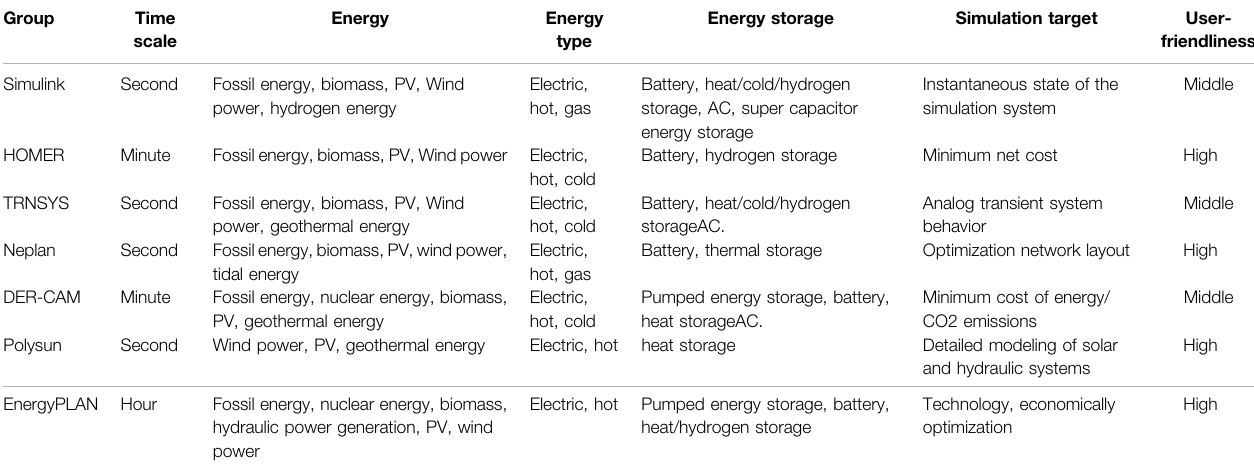
TABLE 4 | summarizes of seven commonly used IES simulation